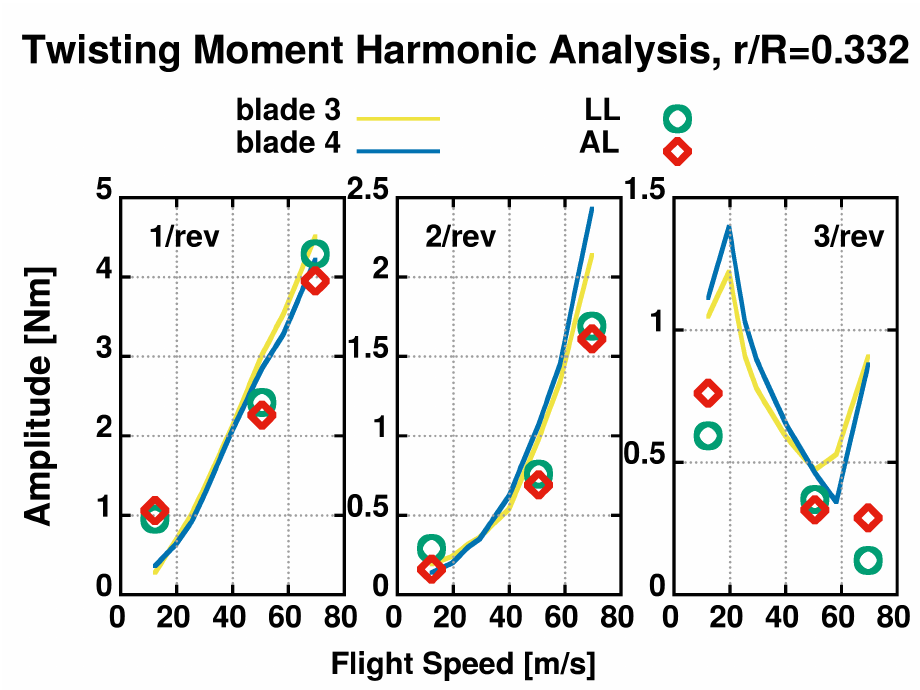
Figure 46. Harmonic analysis of Twisting moment. Amplitude of frequencies with the highest energy content.